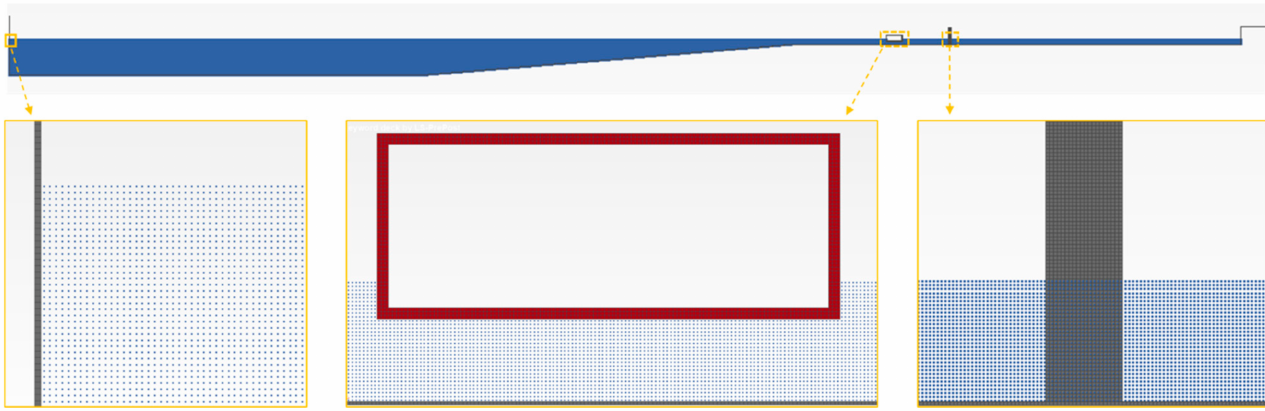
Figure 2. Numerical models with large debris: side-views of the debris, the column and the wave